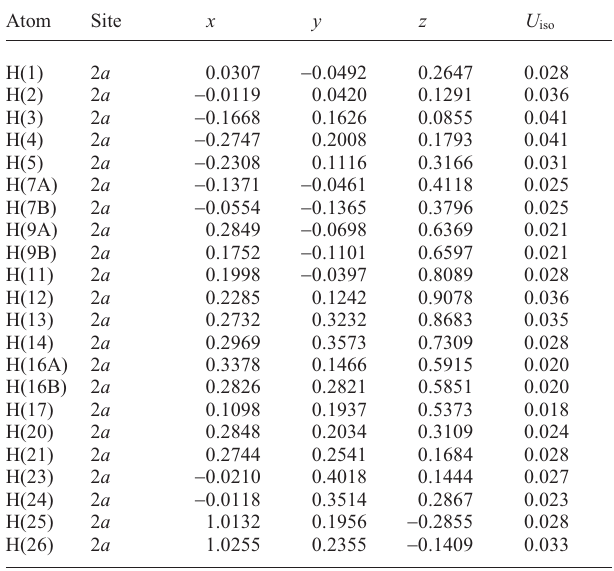
Table 2. Atomic coordinates and displacement parameters (in Å 2 )